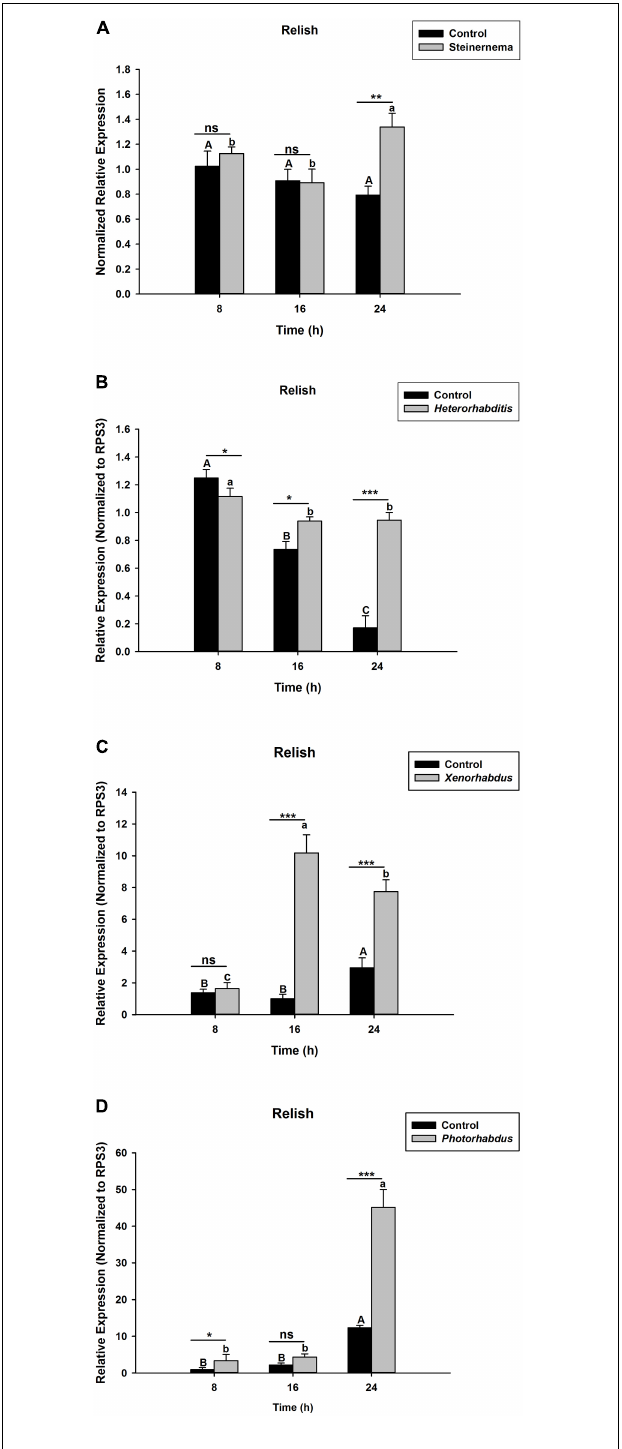
FIGURE 1 | Transcription levels of Relish in O. nipae larvae infected with; (A) S. carpocapsae (B) H. bacteriophora (C) X. nematophila (D) P. luminescens . Error bars labeled with different letters are significantly different (one-way ANOVA followed by LSD test, p < 0.05). ∗∗∗ P < 0.0001; ∗∗ P < 0.001; ∗ P < 0.01 indicates significantly different levels between the control and pathogen treatments at the indicated time period; while “ns” indicates no significant